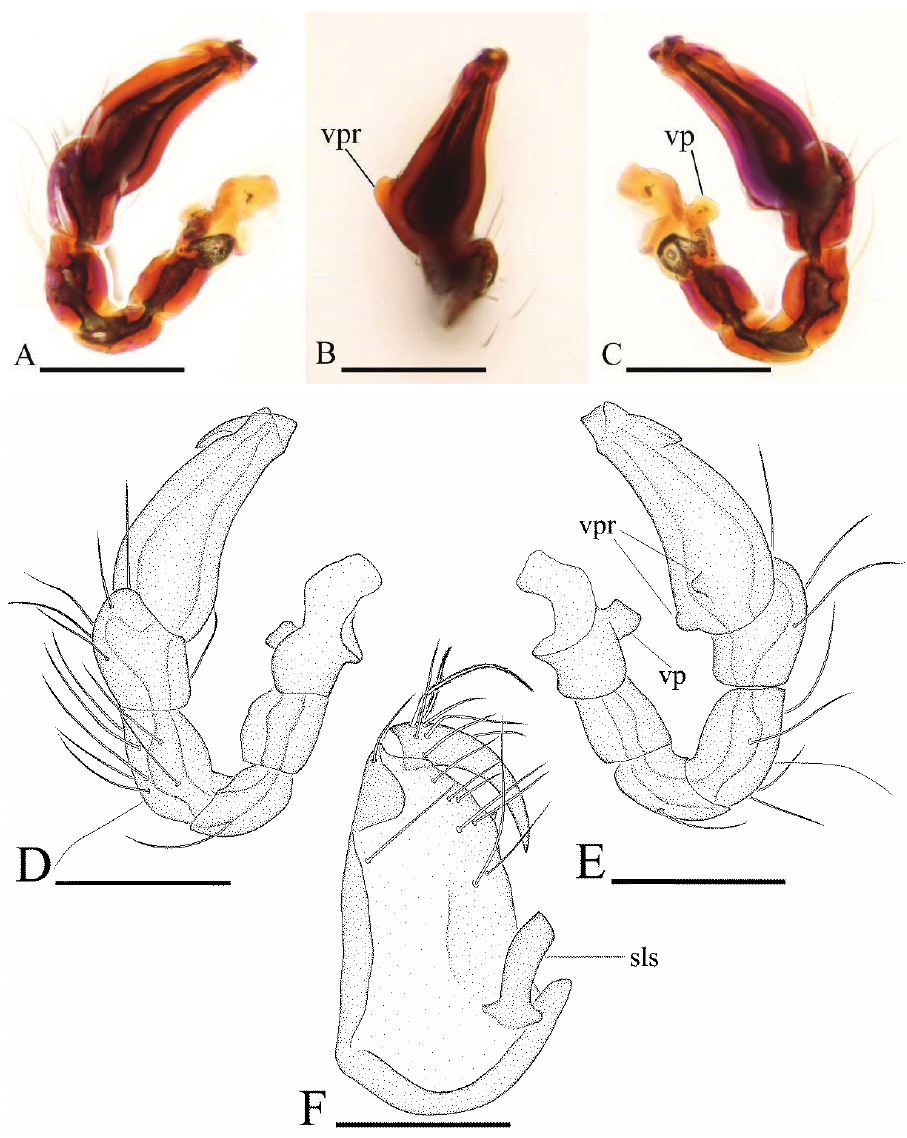
Figure 15. Ischnothyreus tectorius sp. n., male. A, D left palp, prolateral view B left palpal bulb, dorsal view C, E left palp, retrolateral view F left chelicerae, anterior view. Abbreviations: sls = scape-like sclerite; vp = ventral projection; vpr = ventral protuberance. Scale bars: 0.1